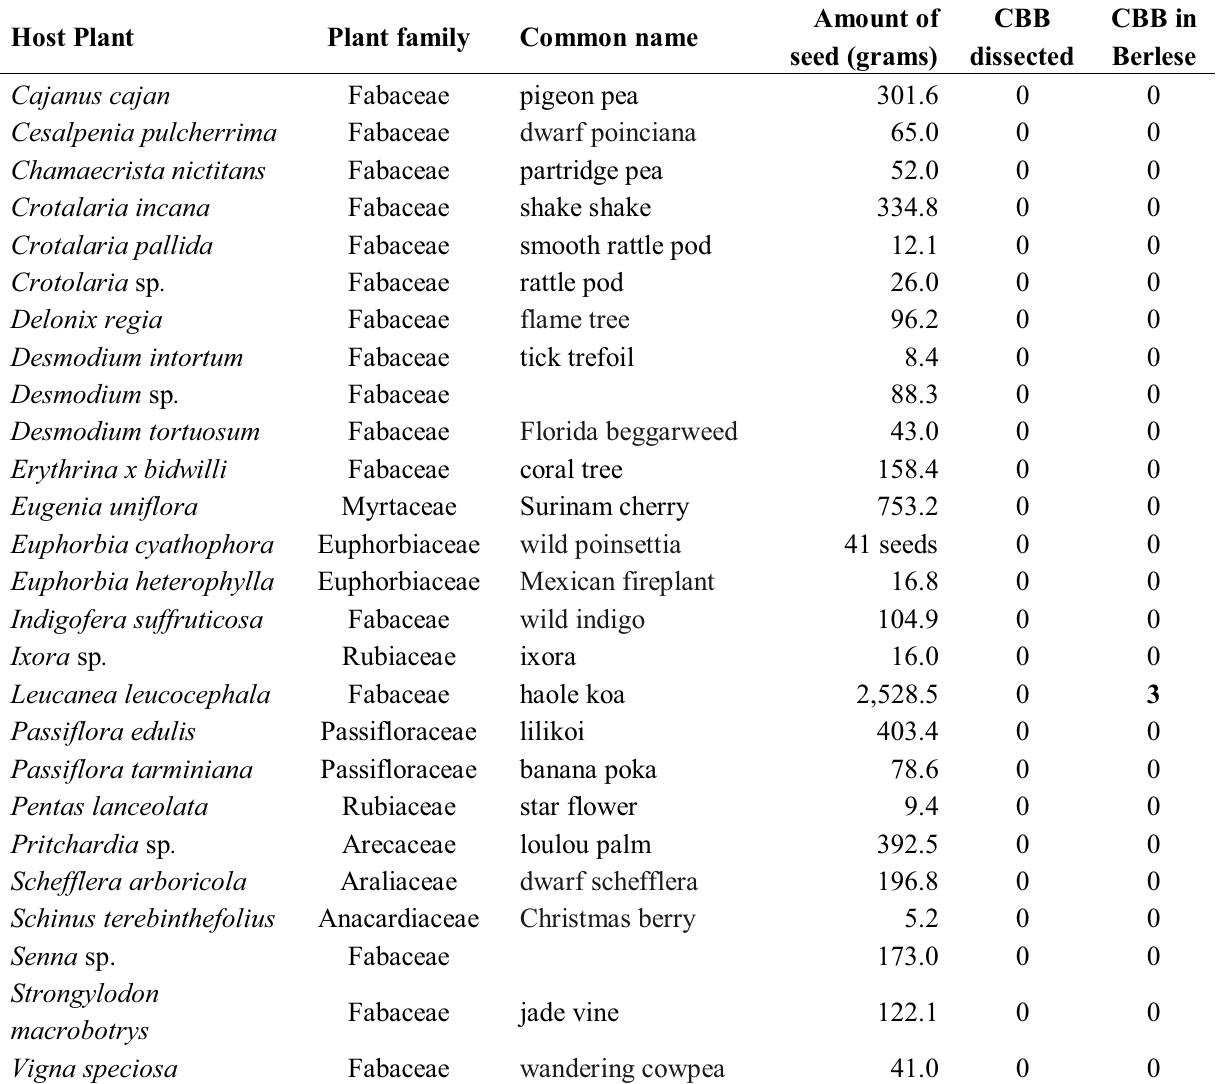
Table 1. Potential alternate host plant seeds examined for presence of coffee berry borer by dissection and by Berlese funnel